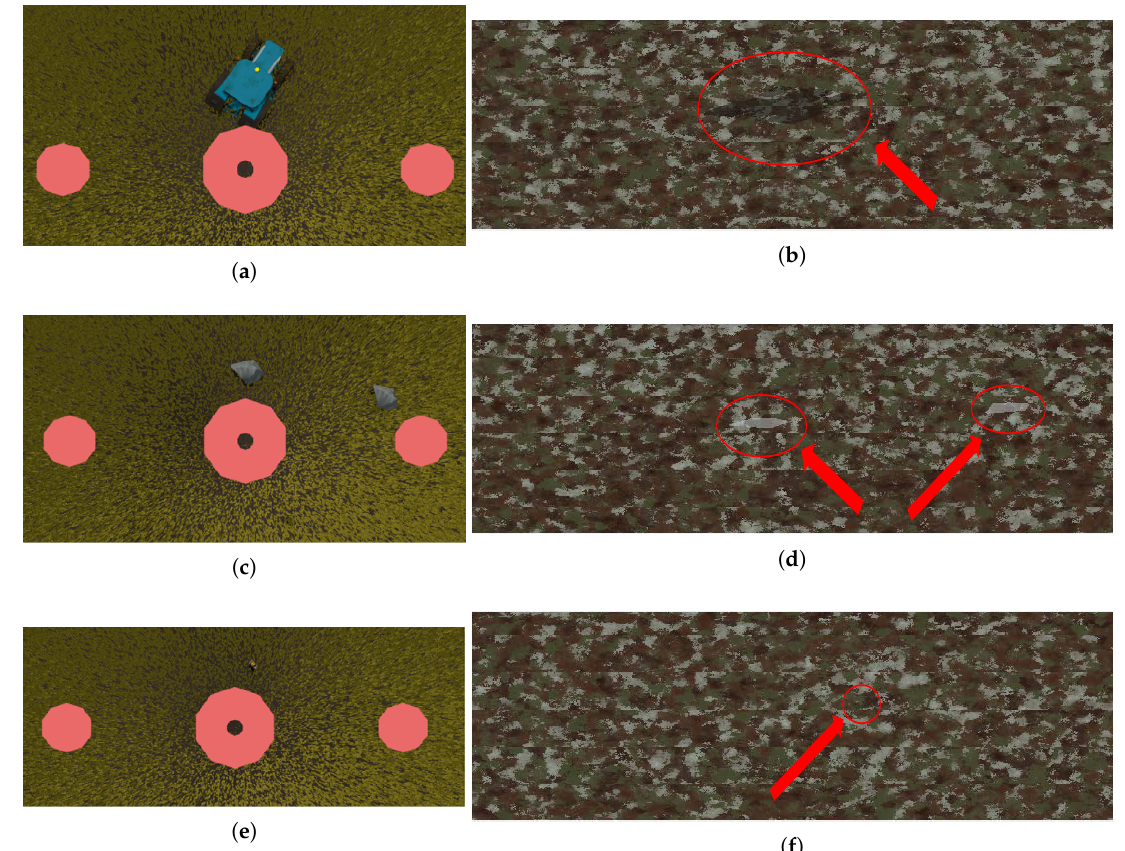
Figure 8. Synthetic image generation based on field ground-truth. On the left hand side captions of the simulator environment view from the drone with some different objects are represented. On the right hand side, the RGB representation of the synthetic image produced from that view are shown. ( a ) Tractor representation; ( b ) synthetic image with the tractor; ( c ) rocks representation; ( d ) synthetic image with rocks; ( e ) person representation; ( f ) synthetic image with a